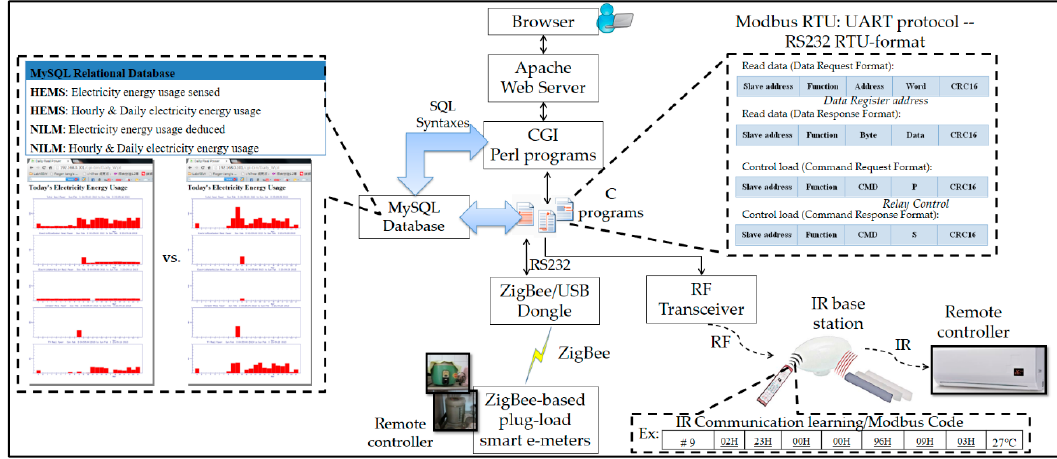
Figure 6. Flow of data stores, signal requests, and controls of electrical appliances monitored in the HEMS.